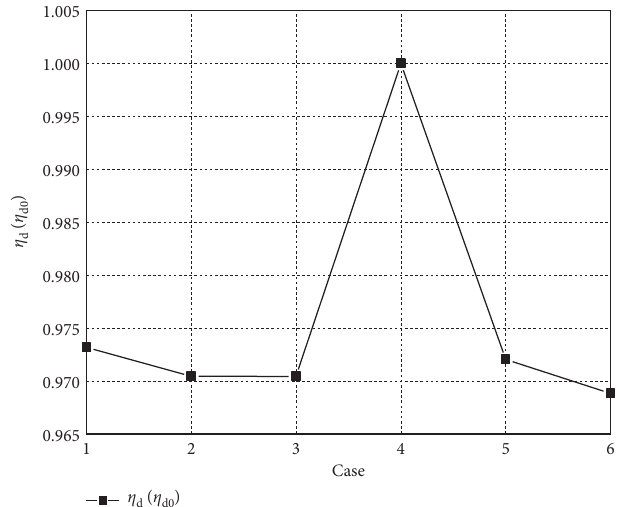
Figure 10: The inlet duct efficiency changes with the length of the inlet